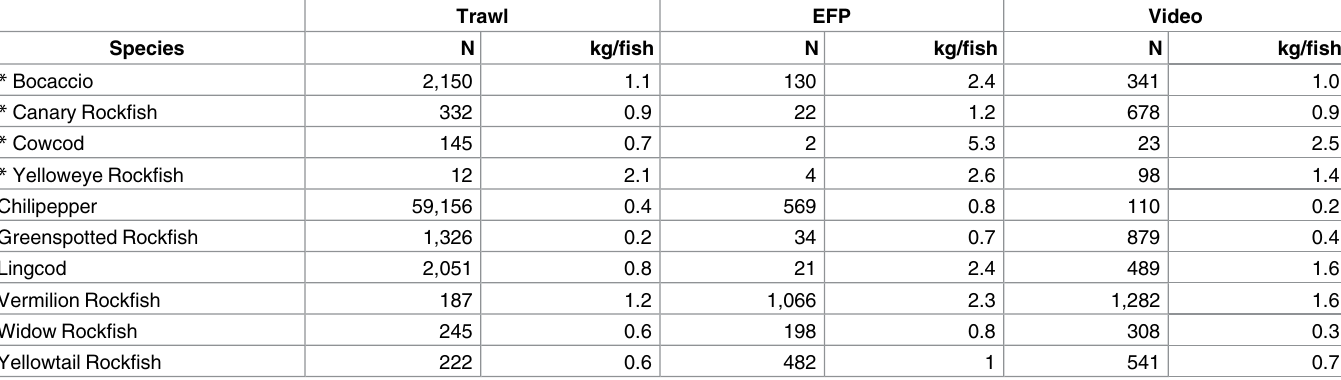
Table 9. Estimatesof the number and mean weight per fish of species caught or observed.